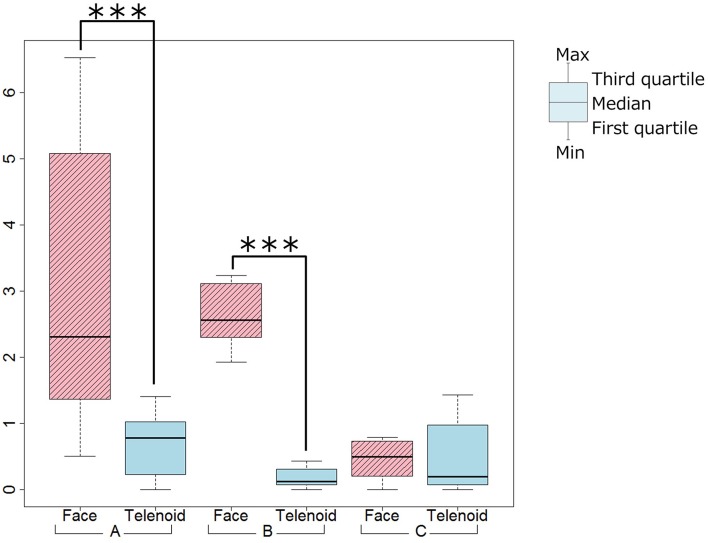
Gesture tendency (*p < 0.1, **p < 0.05, ***p < 0.01).